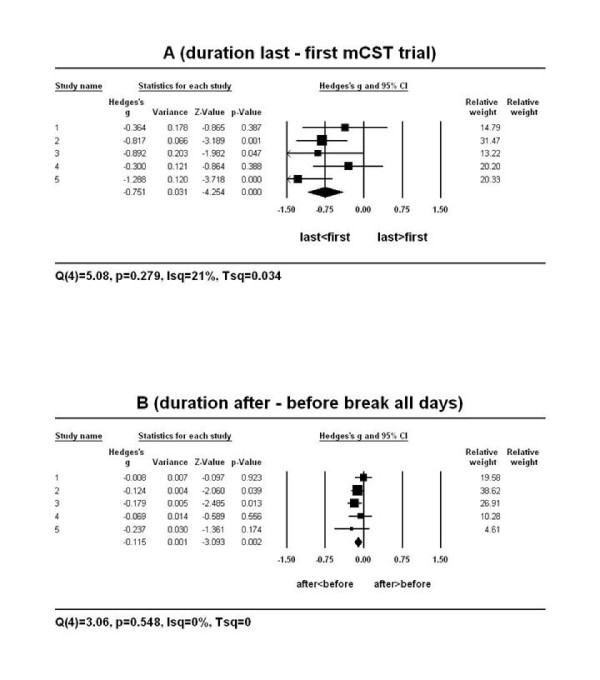
The forest plot of the random-effects meta-analysis on the mean DURATION of performance on the last vs. the first mCST trial (A) and after vs. before the session break on all experimental days (B). Positive effect sizes (Hedges' g represented as boxes on the plot) indicate a slower while negative effect sizes indicate a faster duration of performance on the last vs. the first mCST trial or after vs. before the break. The 95%C.I. of some effect sizes (the horizontal lines through the boxes) overlapped with zero. The mean weighted effect sizes g (the centre of each diamond in A and B) were medium (A) and small (B) and their 95%C.I. (the edges of the diamonds) did not overlap with zero. Therefore, the mean overall effect sizes show that participants performed the task faster in the long-term (last vs. first mCST trial; A) and short-term (after vs. before the break within each session; B). The relative weights indicate that the study 2 in A and B had the highest contribution to the computation of the mean weighted effect sizes.